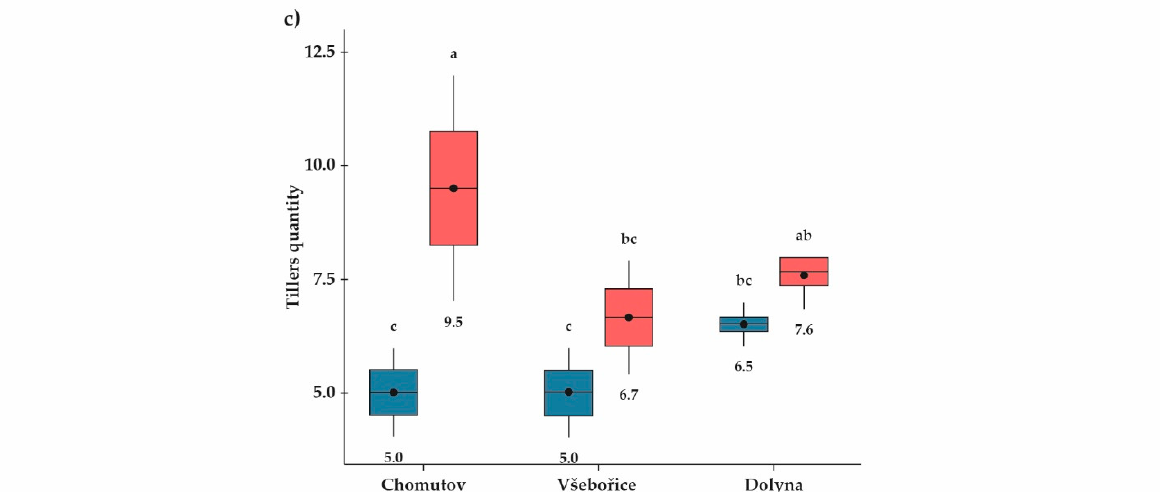
Figure 8. Influence of Charkor on biomass productivity in the different soils: ( a ) AGB DW; ( b ) plant height; ( c ) tillers quantity. Different letters indicate a significant difference between the values within one physiological parameter ( p < 0.05).